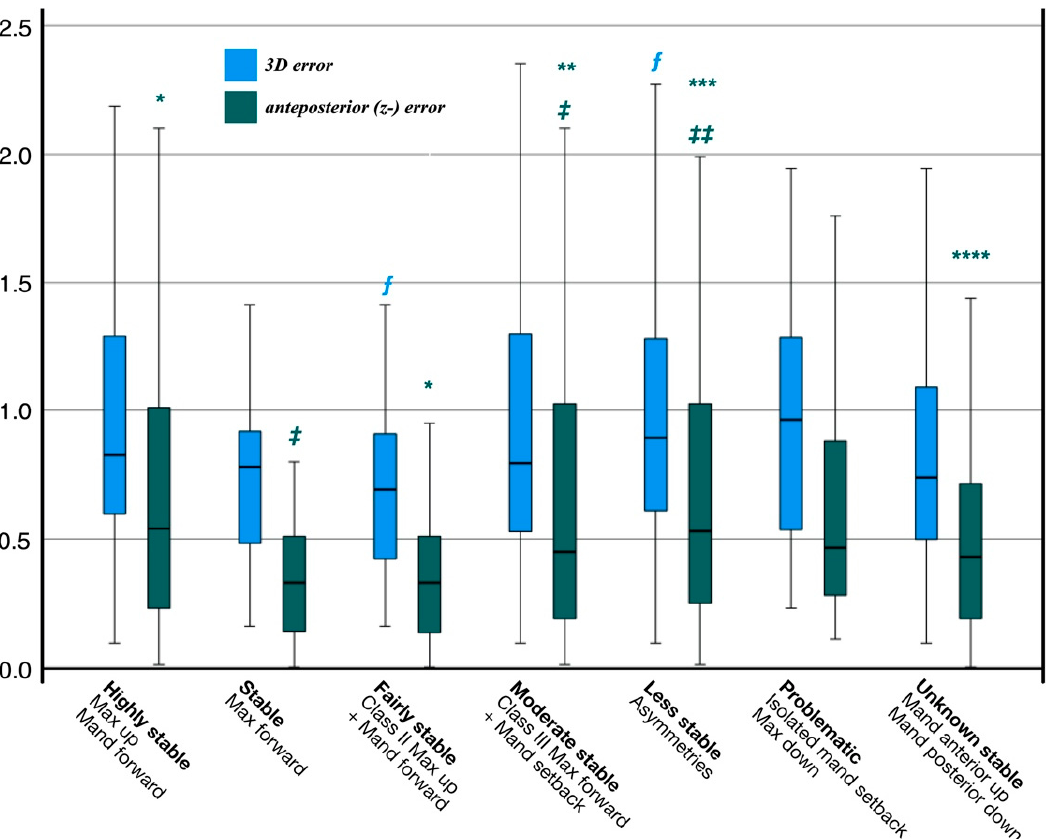
Figure 4. Surgical movements grouped by the hierarchy of stability in orthognathic surgery [6]. There are significant differences in three-dimensional and anteroposterior distances between virtual planning and postoperative outcome (see also Table 3). The lowest errors are seen in stable and fairly stable procedures and differ significantly from moderate, less, and unknown stable procedures. The procedures mandible anterior up and posterior down are not included in the hierarchy of stability and are therefore referred to as unknown stable. * to *; ‡ to ‡; ** to **; *** to ***; ‡‡ to ‡‡, **** to **** indicates significant anteposterior (z-) error between procedures. ƒ to ƒ indicates significant 3D error between procedures.